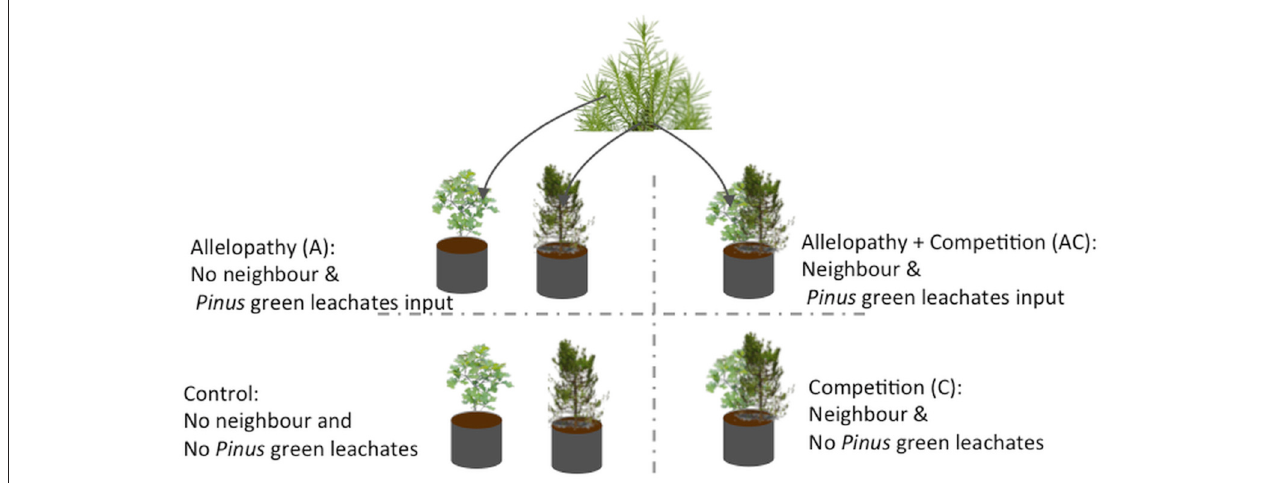
FIGURE 1 | Diagram of factorial design utilized for experimentation. Three interference treatments and one control were tested on Pinus and Quercus saplings: allelopathic treatment was applied by application of Pinus needle aqueous extract; competition treatment through neighbor presence; allelopathy + competition treatment through neighbor presence plus application of Pinus needle aqueous extract; and control treatment.